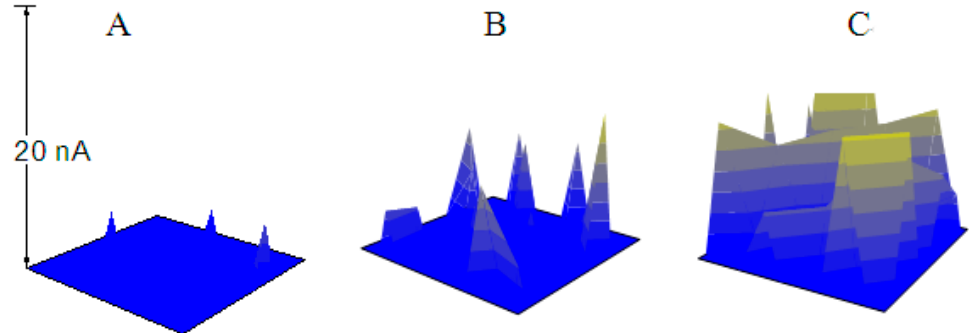
Figure 2. The relationship between the critical pitting potential ( E pit ) and the concentrations of Na 3 PO 4 or NaNO 2 (c).